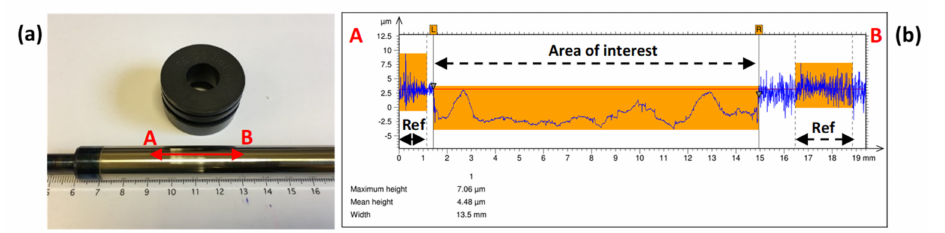
Figure 7. ( a ) Hard anodized Al rod guide and Ni variant I coated rod after wear testing, and ( b ) indicative wear profile measured in the middle of the wear track on this rod, along the sliding direction